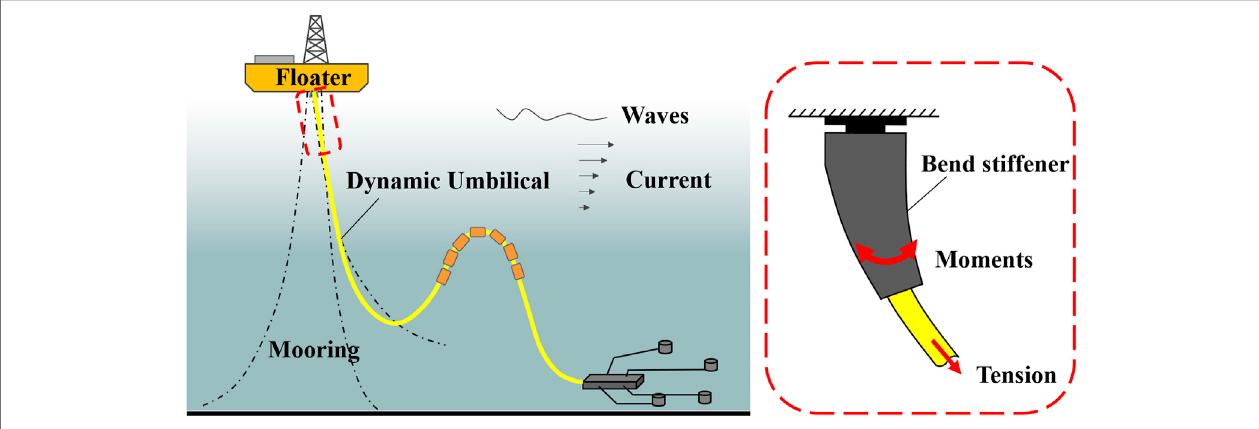
FIGURE 1 | In-place working condition of dynamic umbilical.